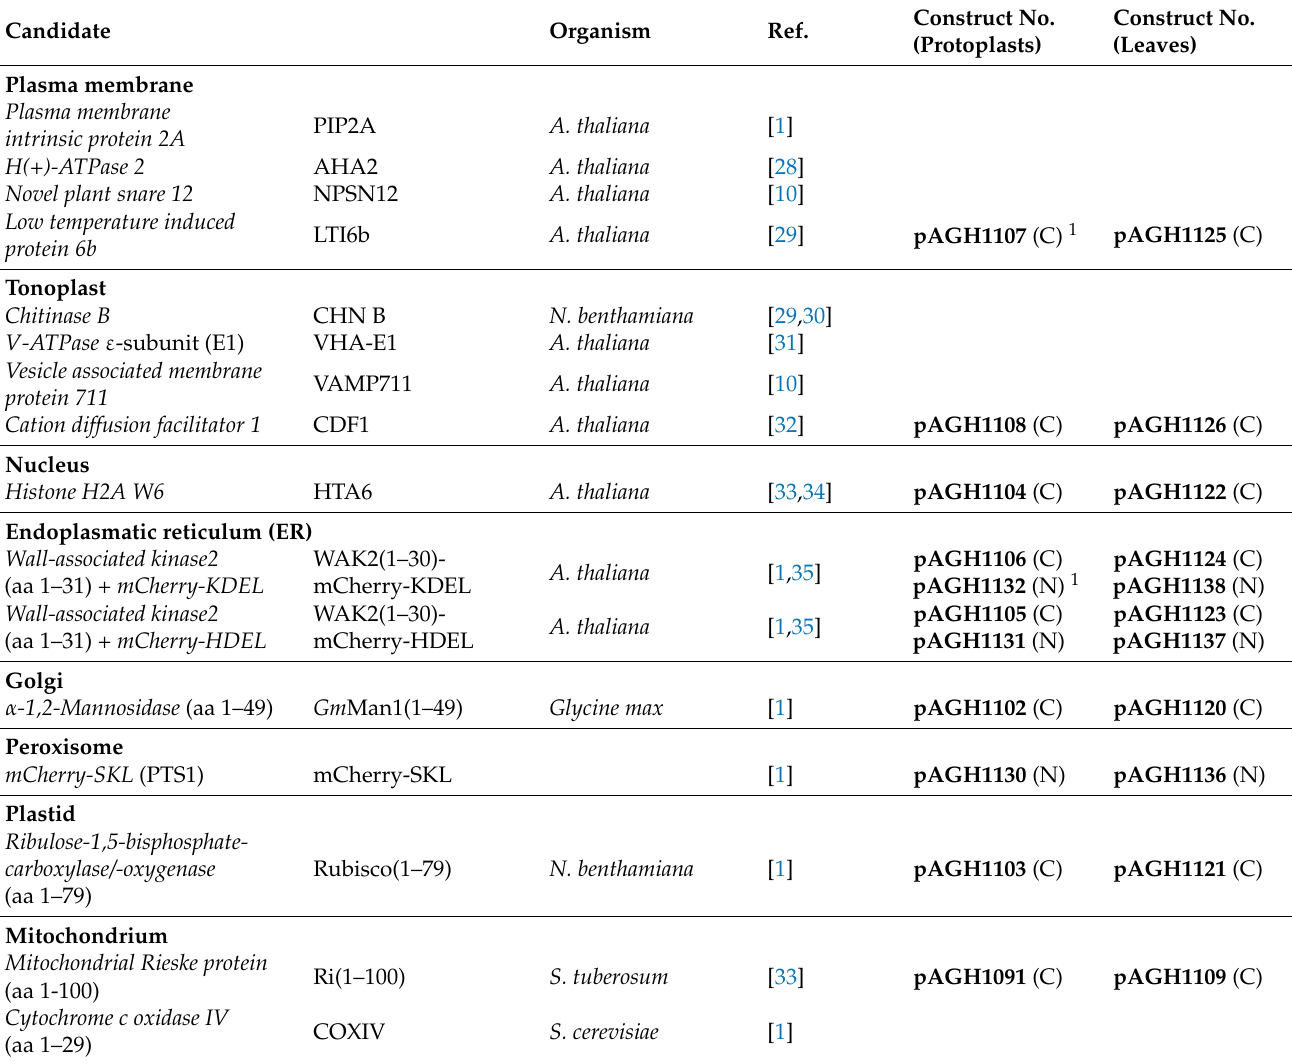
Table 1. Overview about the proteins/genes selected as putative organelle markers. Organism